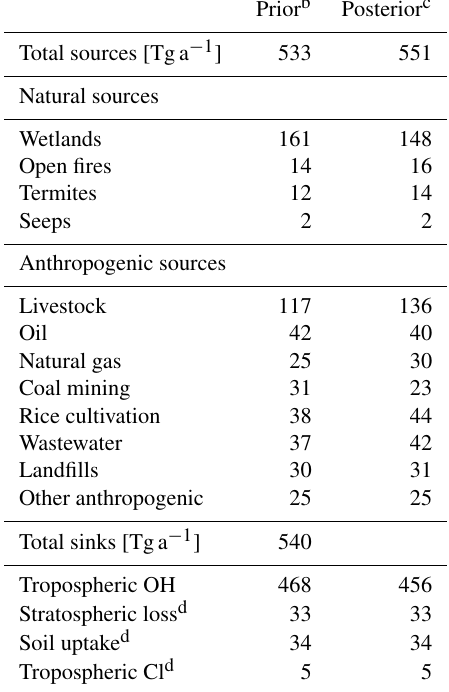
Table 1. Global sources and sinks of atmospheric methane,